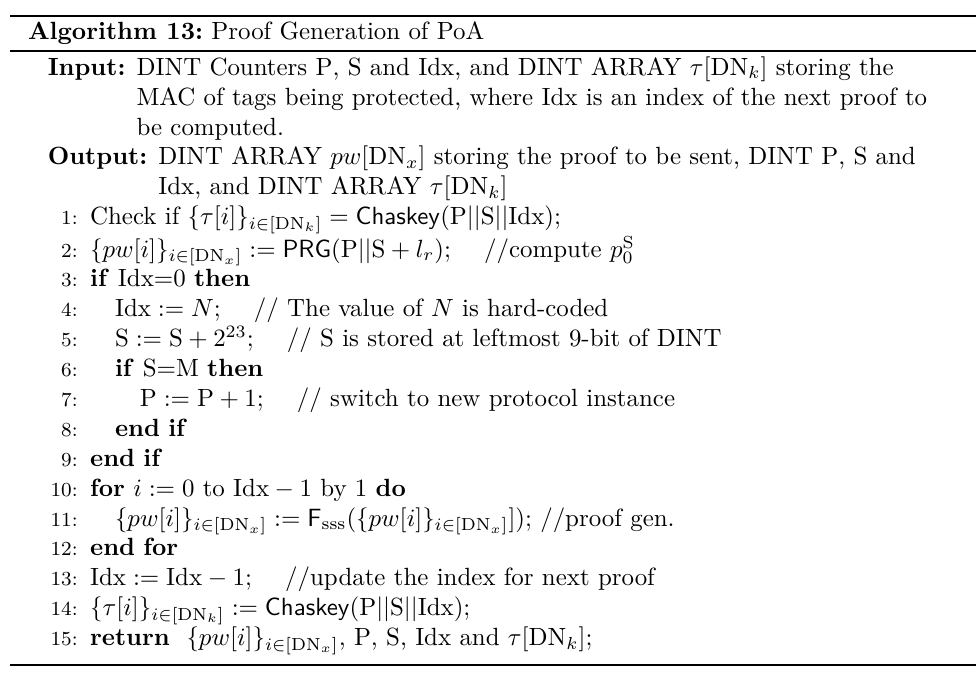
Algorithm 13: Proof Generation of PoA